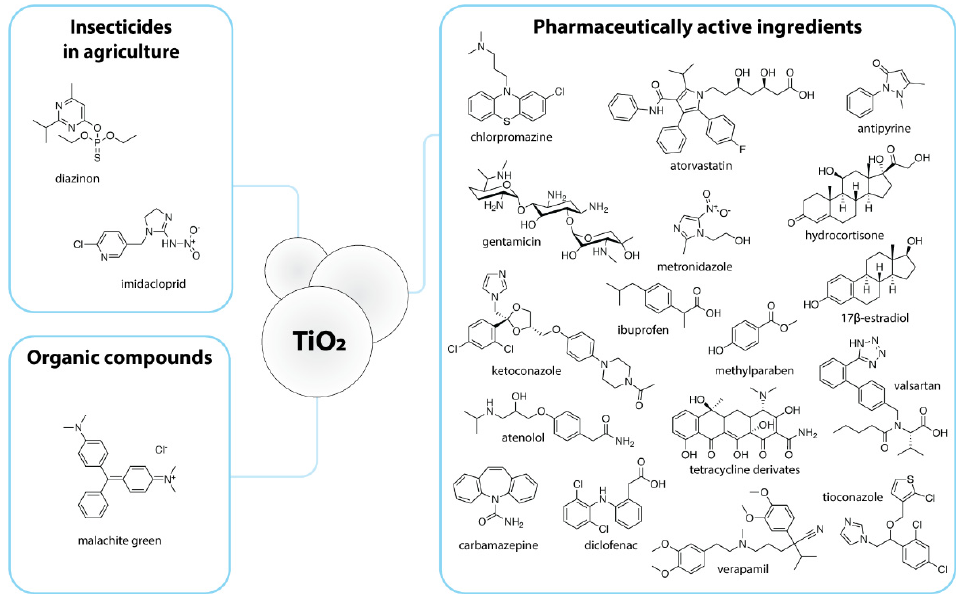
Figure 5. The applicability of TiO 2 as a catalyst in the photodegradation studies of various insecticides in agriculture, pharmaceutically active ingredients, and selected organic compounds including dyes.